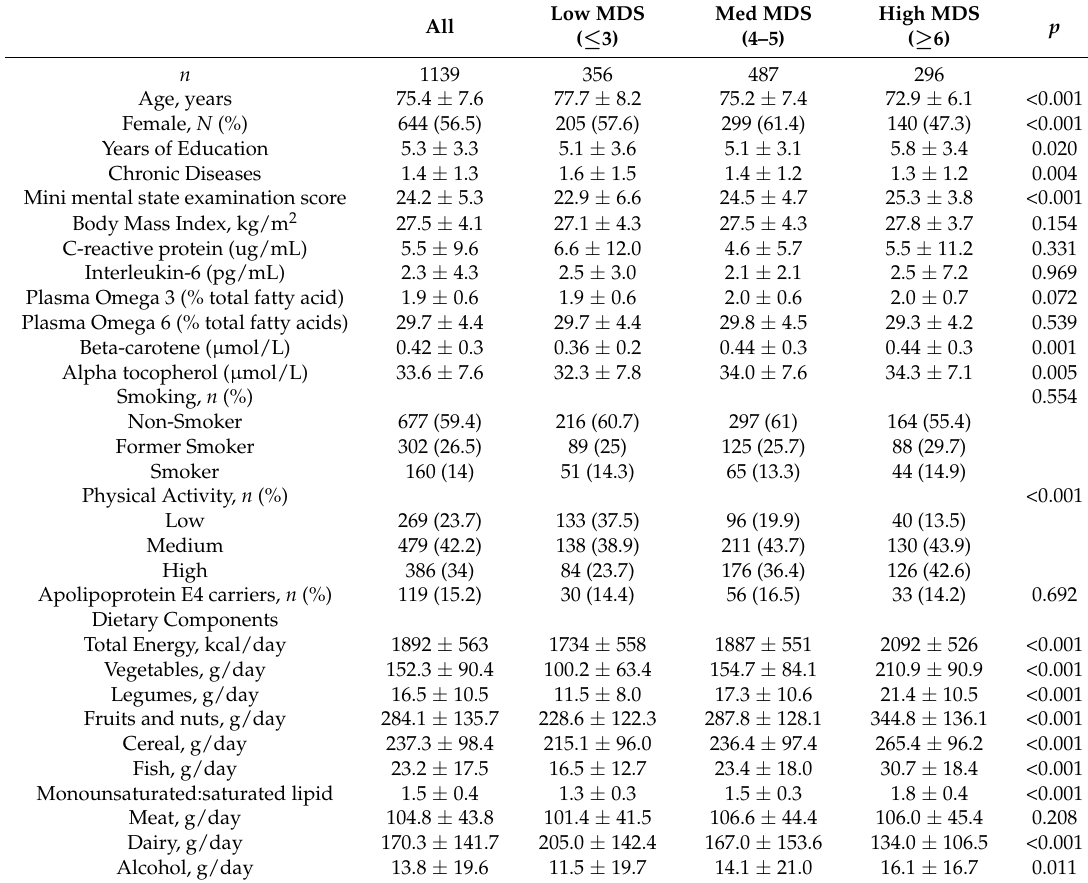
Table 1. Characteristics of the InChianti study participants aged 65 y and older at